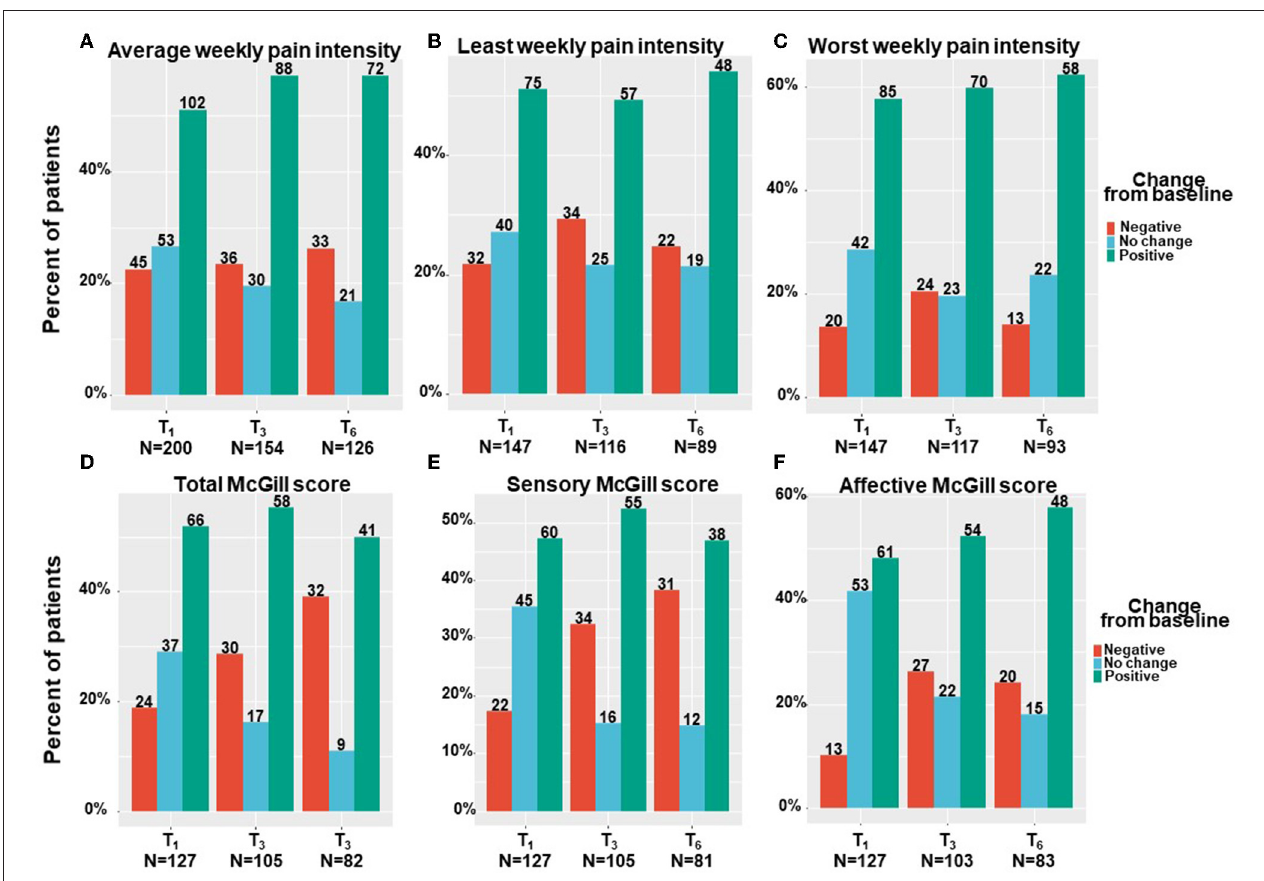
FIGURE 2 | Pain measures change from baseline per time point. T 1 , 1-month Follow-Up; T 3 , 3-month Follow-Up; T 6 , 6-month Follow-Up: Negative indicate patients that reported on higher pain intensity at a follow-up compared to baseline; Positive indicate patients that reported on lower pain intensity at a follow-up compared to baseline; No change indicate patients that reported on the same pain intensity at a follow-up compared to baseline; Numbers of patients are based on patients that reported fully on the measures at baseline and at the corresponding follow-up time point.